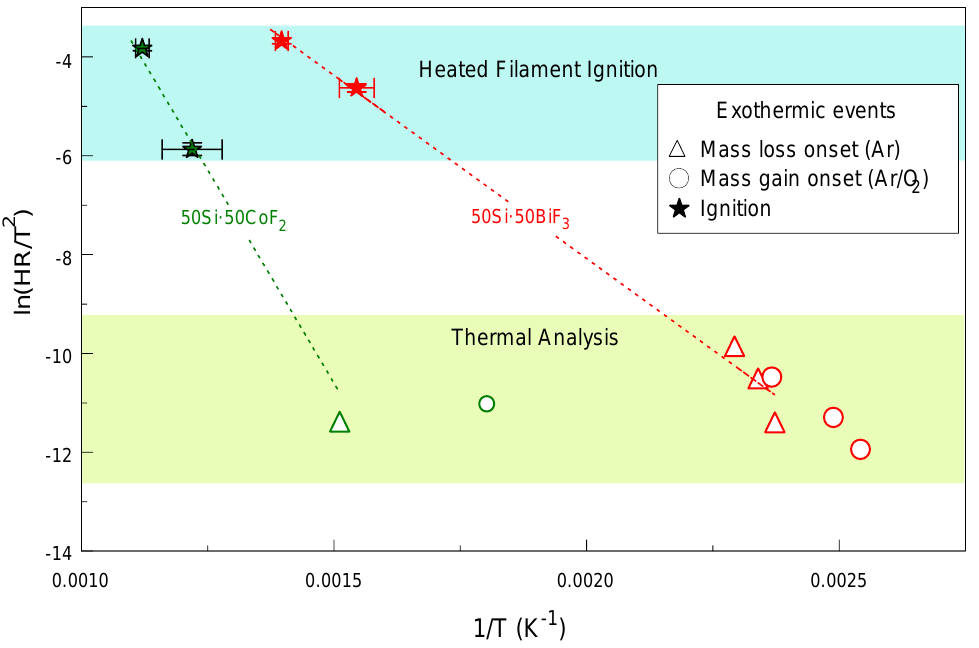
Figure 17. Kissinger plot combining TG and DTA features and heated filament ignition data for two-stage milled 50Si·50BiF 3 and 50Si·50CoF 2 .